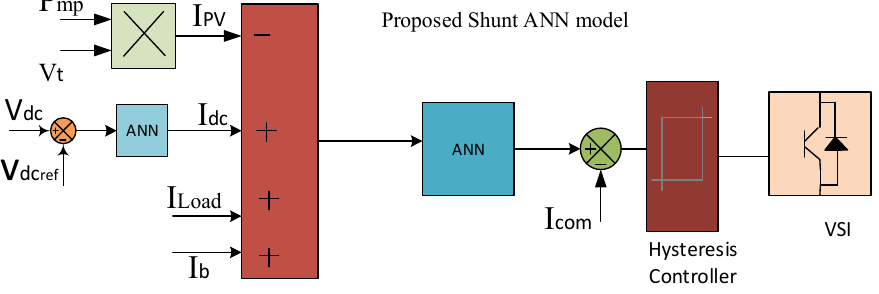
Figure 10. Block diagram of Shunt ANN model.